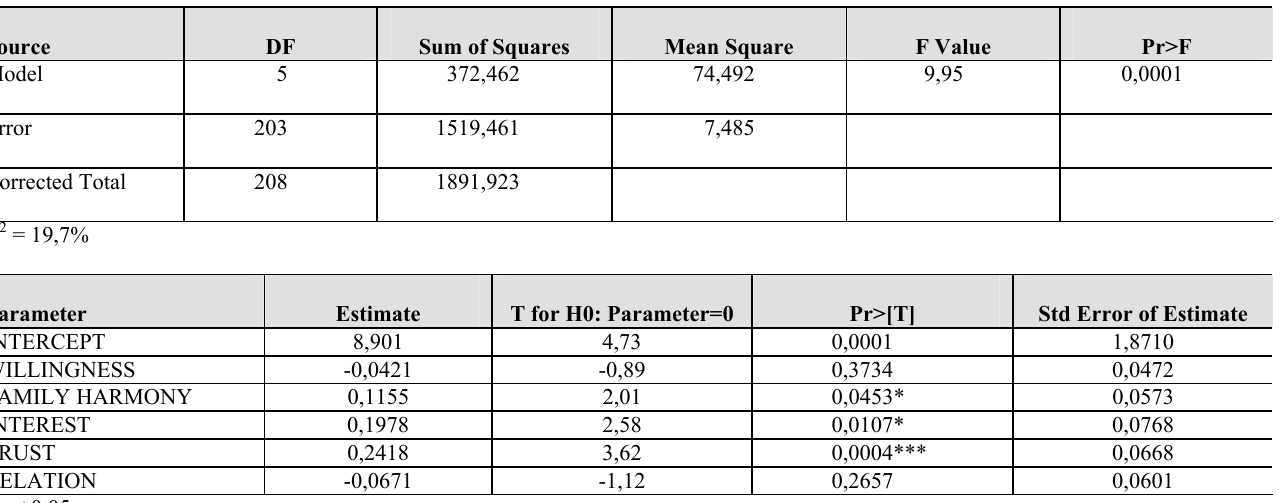
Table 4: Multiple regression results for successor sub-sample: Satisfaction